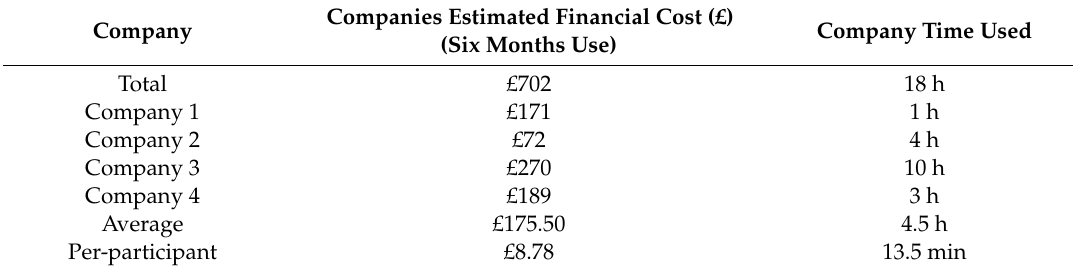
Table 7. Estimated financial cost and time used to implement the intervention.